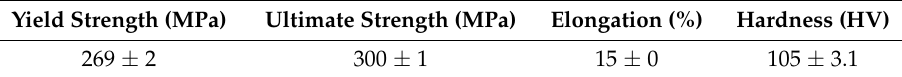
Table 2. Mechanical properties of the 6061-T6 aluminum